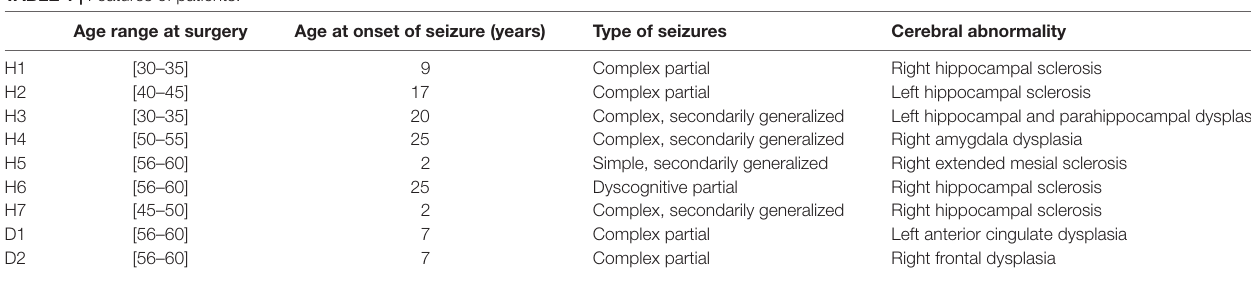
TABLE 1 | Features of